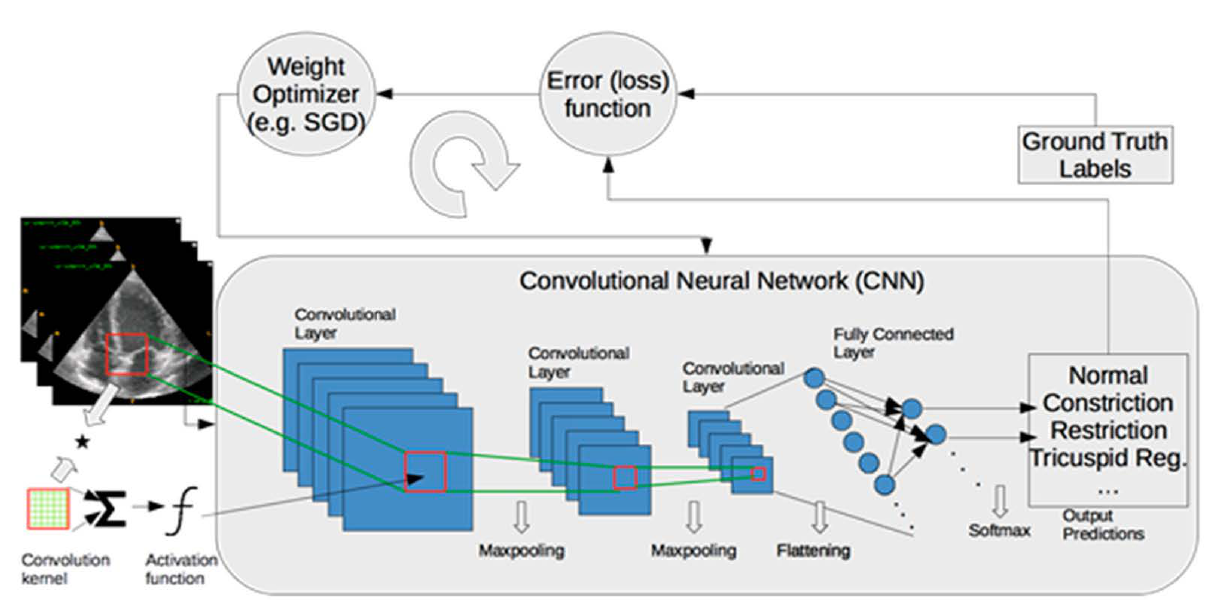
Figure 3. A framework of training a deep-learning model for classification of myocardial diseases. Operations between layers are shown with arrows. SGD: Stochastic Gradient